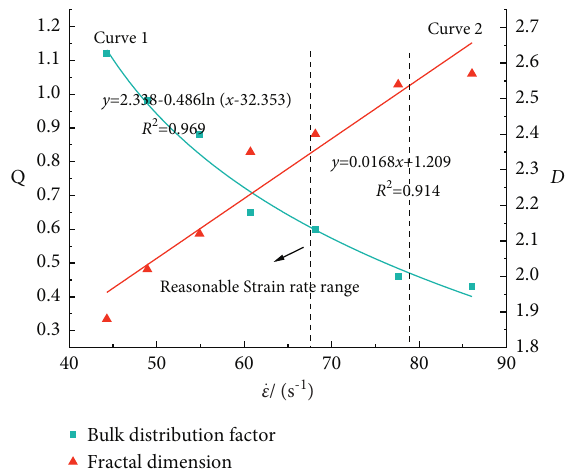
Figure 13: The relationship diagram for determining the rea- sonable strain rate